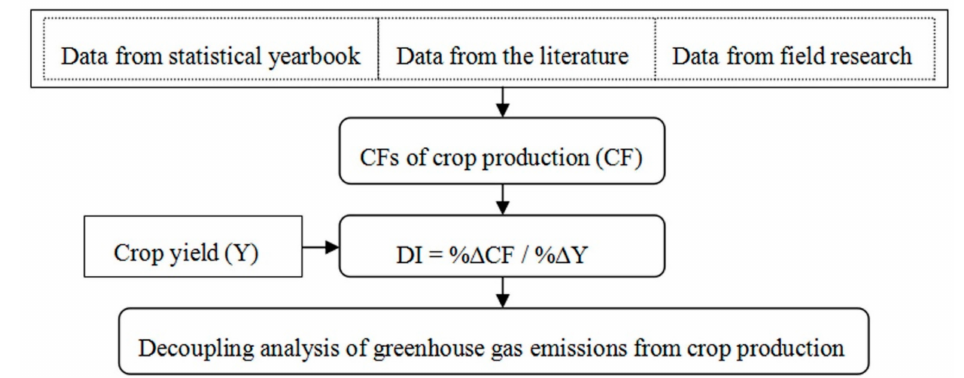
Figure 1. Steps in the decoupling